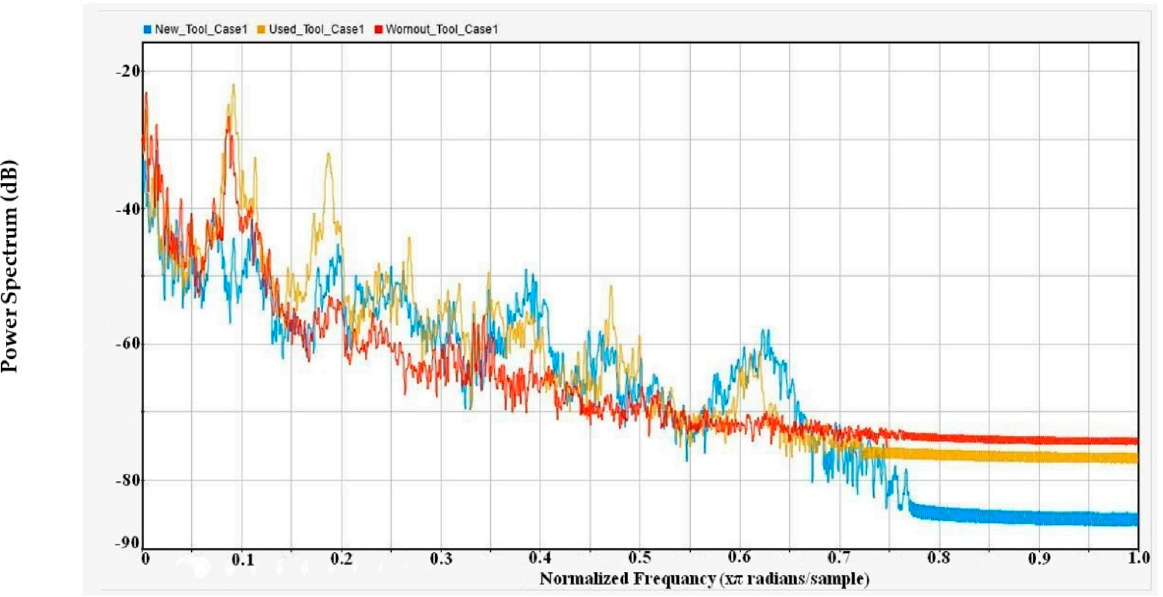
Figure 16. Power spectral density (PSD) for Case-1 of new (blue), used (yellow), and worn-out (red) tool with maximum leakage